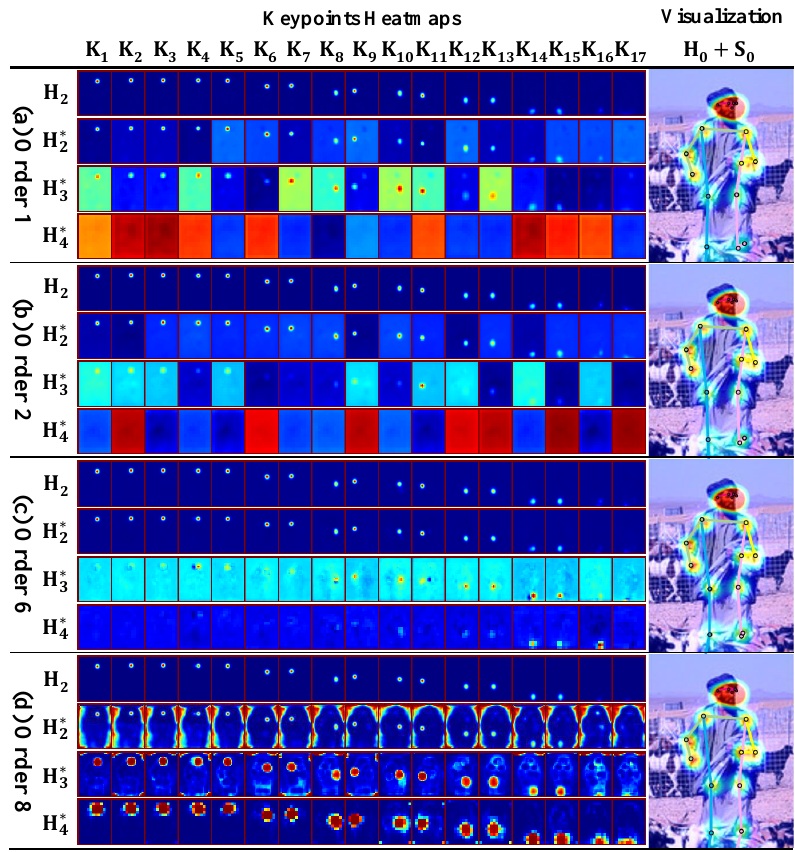
Figure 9. Visualization of the final outputs. ( a ) The outputs of Order 1, which means the baseline EffBase. ( b ) The outputs of Order 2 where the backbone is MEMe-based. ( c ) The outputs of Order 6 whose backbone and neck are both MEMe-based. ( d ) The outputs of Order 8, which is our final MEMe-based model EEffPose. K N is the heatmap of keypoint while H ∗ and H 2 are the multi-scale J outputs, and the final one integrated as Equation (6) for ( a – c ) or Equation (7) for ( d ). For a better comparative observation, we upsampled H ∗ as the same scale as H 2 . The S 0 +H 0 means S 0 (the input J image) overlaps with all keypoint heatmaps to demonstrate the detection results of the